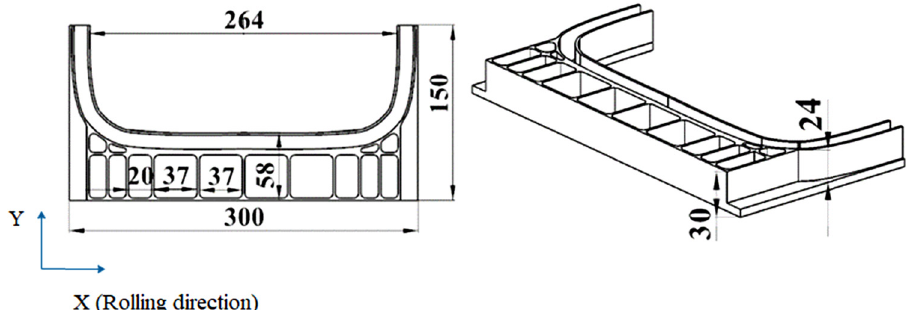
Figure 1: Size and shape of thin - walled specimen.